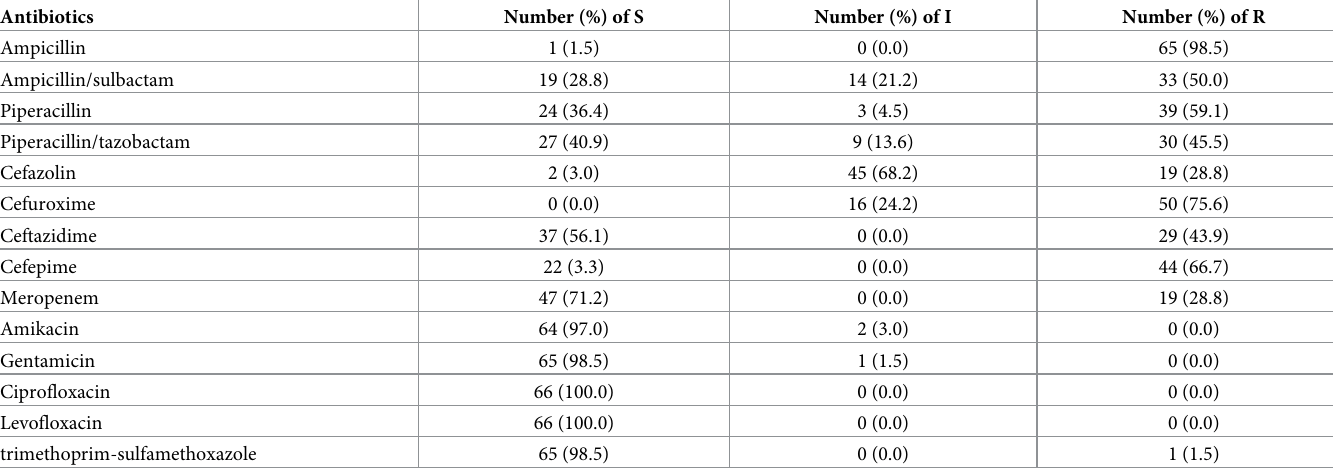
Table 6. Antibiotics resistance profiles of clinical V . parahaemolyticus